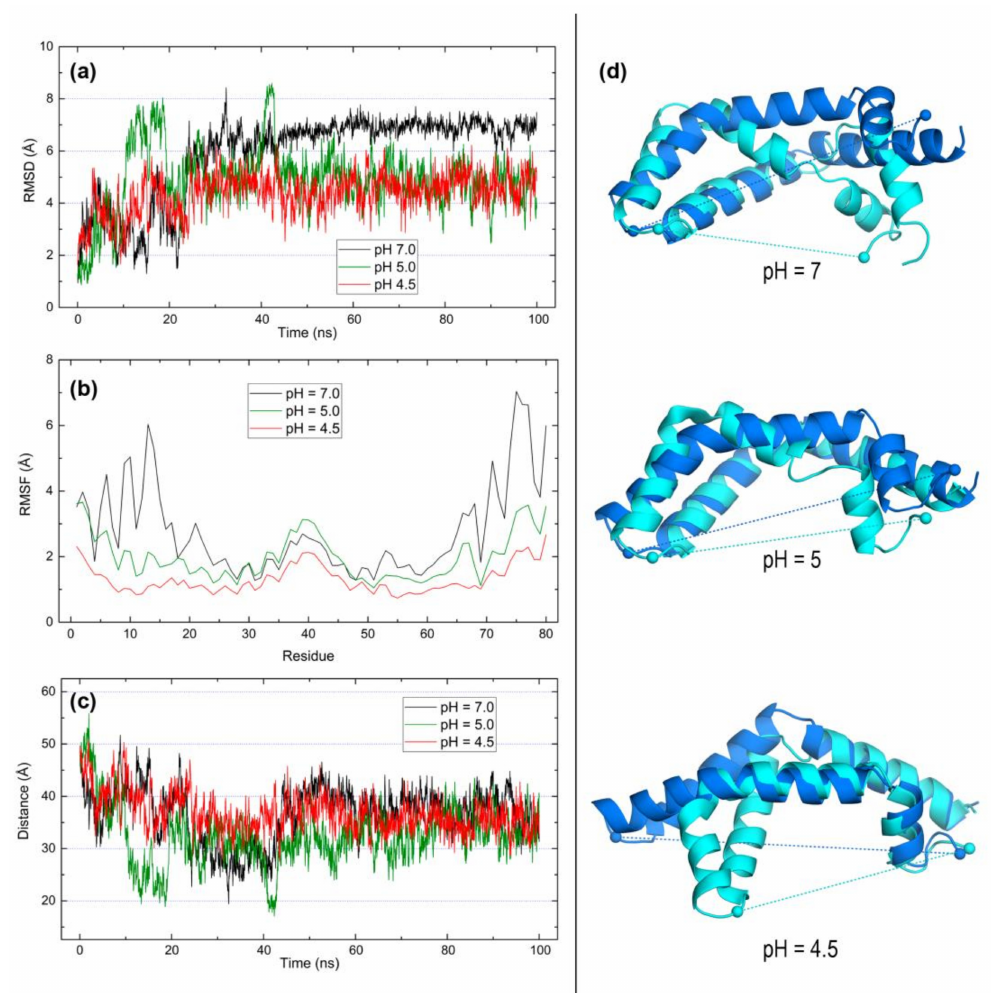
Figure 6. Results of 100-ns MD simulations on the open form of saposin A (4DDJ) at pH 7, 5, and 4.5. ( a ) RMSD of backbone atoms. ( b ) RMSF of all residues. ( c ) Distance between alpha carbons of P39 and E80 residues. ( d ) Structural superposition of initial (blue) and final (cyan) structures in the simulations computed with TM-Align [42]. Dashed lines indicate distances between C α atoms of P39 and E80 represented as